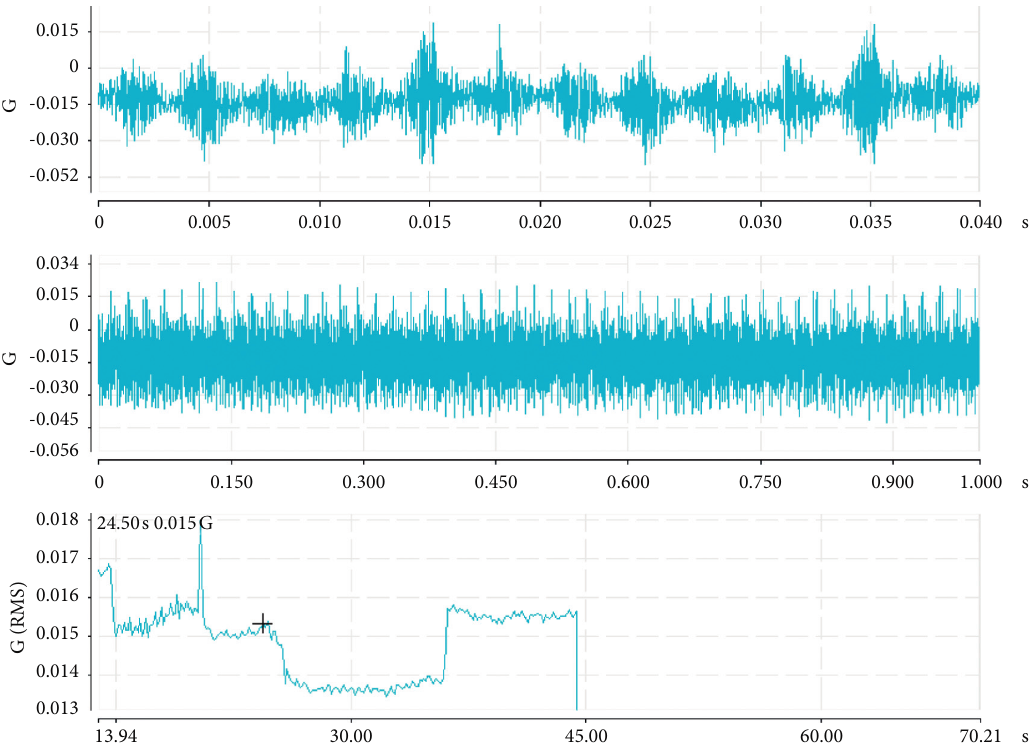
Figure 26: The result of the